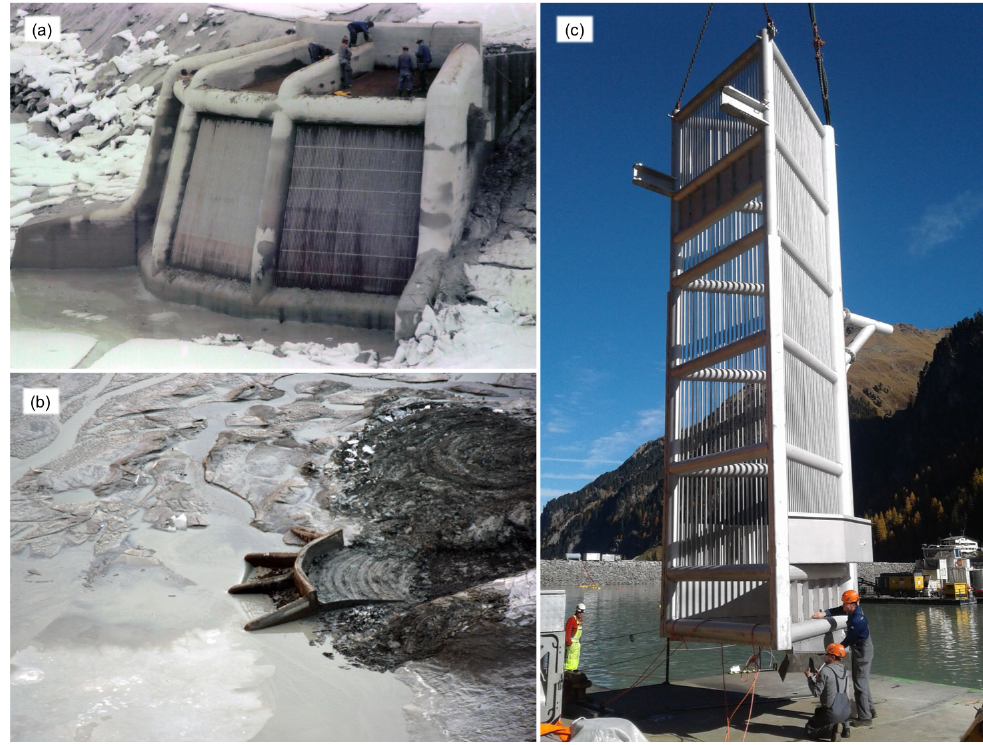
Figure 1. Archive picture of the lower intake structure ( a )—situation end of 2015 with the increase sediment level ( b )—final works on one trash rack structure (intake tower) near the installation location ( c